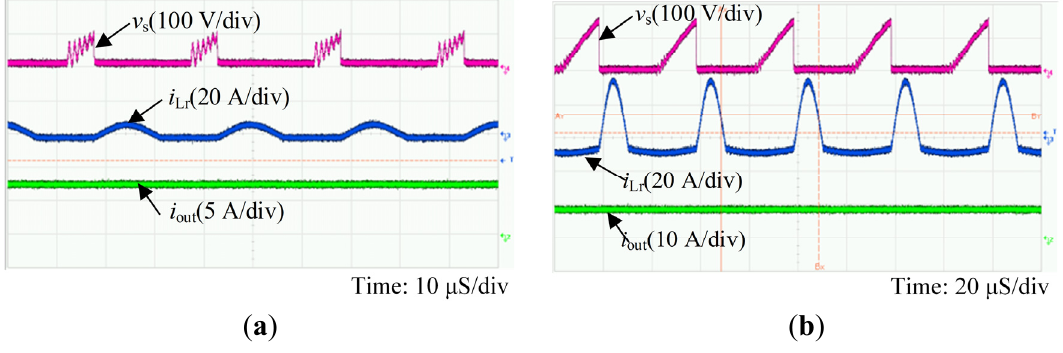
Figure 22. Experimental results under the constant voltage charging stage ( a ) 106.8 V out; ( b ) 110 V